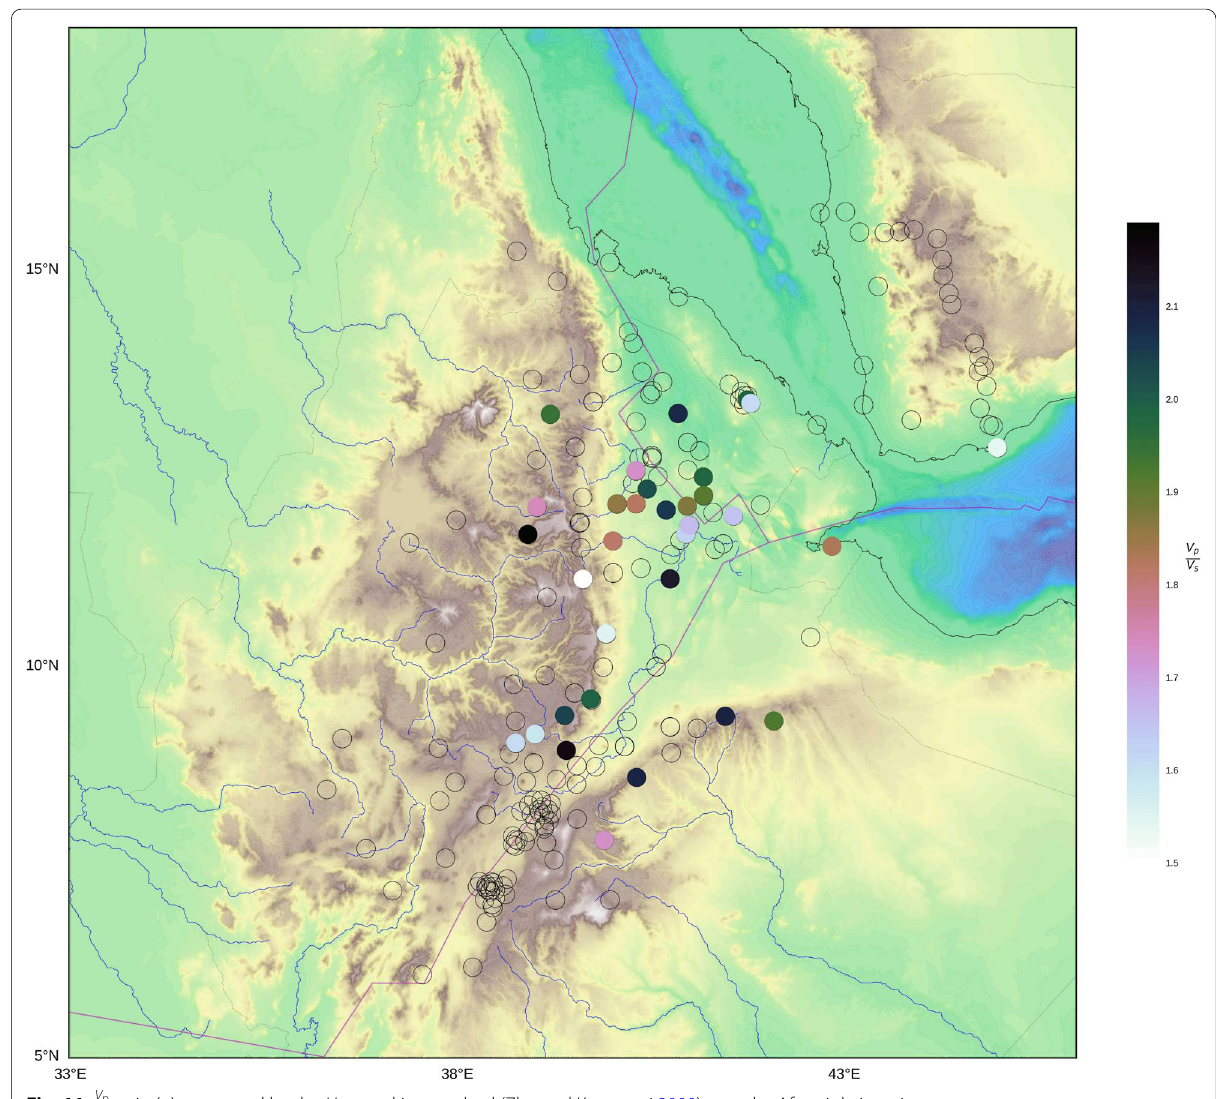
V p κ ) computed by the H – κ stacking method (Zhu and Kanamori 2000) near the Afar triple Fig. 11 V s ratio (